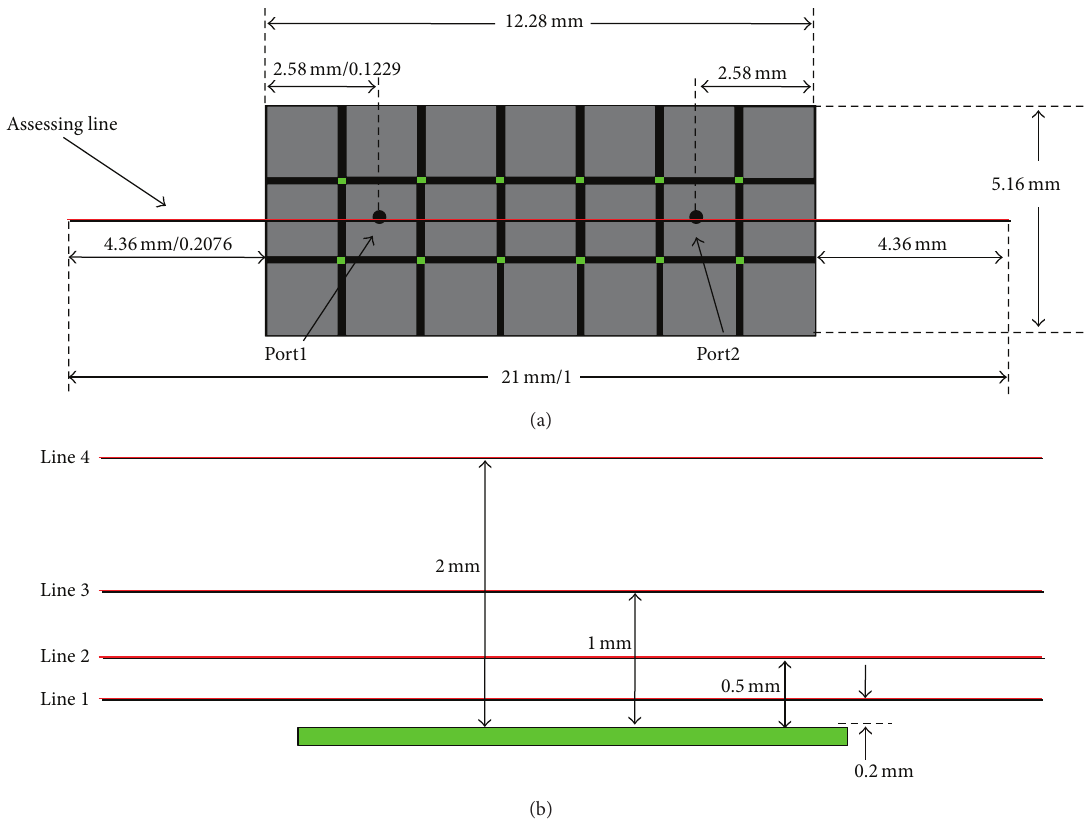
Figure 14: (a) Top view and (b) the side view of the EBG-patterned parallel planes and four assessing lines used to compute fields in the near zone. The dimensions are labeled in the figures. The distances along the assessing lines are shown in metric system and normalized